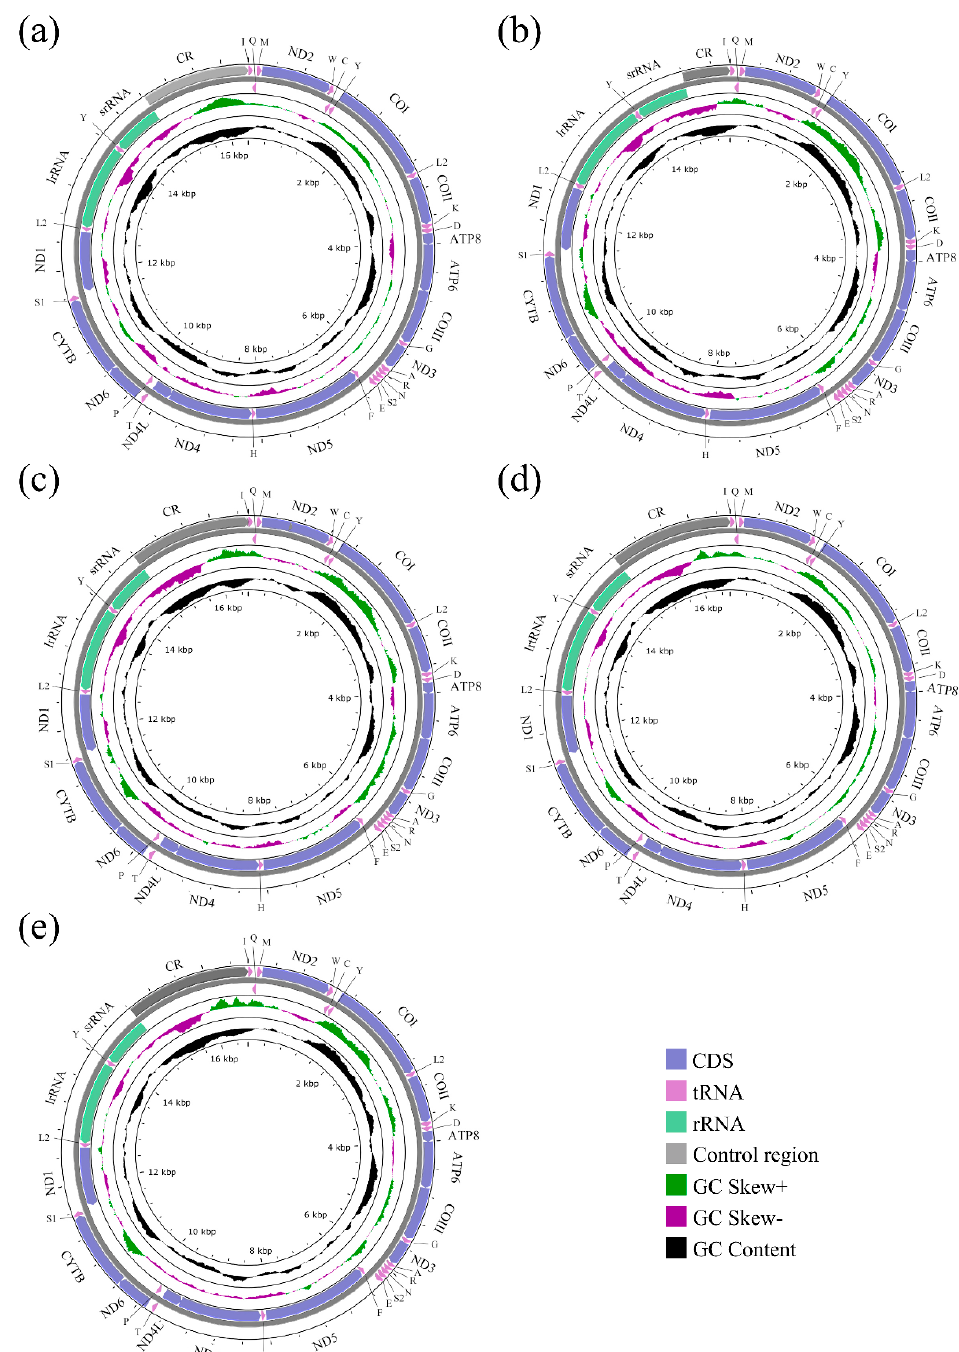
Figure 1. Agria mihalyii ( a ), Blaesoxipha lapidosa ( b ), Taxigramma karakulensis ( c ), Wohlfahrtia balassogloi ( d ), and Wohlfahrtia fedtschenkoi ( e ). The strands are marked with arrows that indicate the direction of gene transcription. Gene lengths correspond to the length of their nucleotides. The IUPAC-IUB single-letter amino acid codes assign one-letter symbols to tRNA genes. Gene names were represented by their abbreviations: COI–COIII, cytochrome oxidase subunits 1–3; CYTB, cytochrome b; ND1–6 and ND4L, NADH dehydrogenase subunits 1–6 and 4L; ATP6 and ATP8, ATP synthetase subunits 6 and 8; lrRNA and srRNA, large and small ribosomal RNA subunits; CR, control region. The whole mitogenome for each of A . mihalyii , B . lapidosa , T . karakulensis , W . balasso- gloi , and W . fedtschenkoi was biased towards A and T, with the AT content being 74.43%,